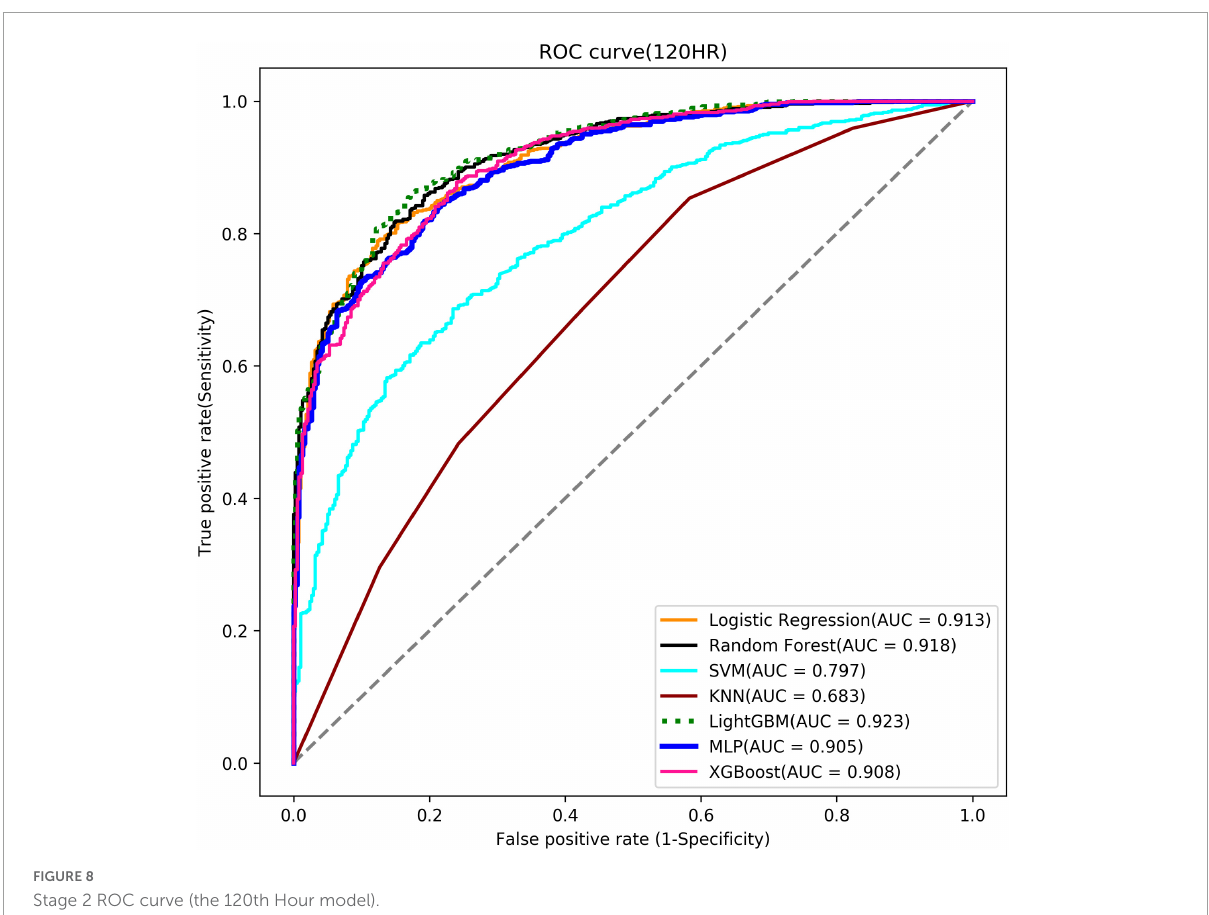
FIGURE8 Stage 2 ROC curve (the 120th Hour model).